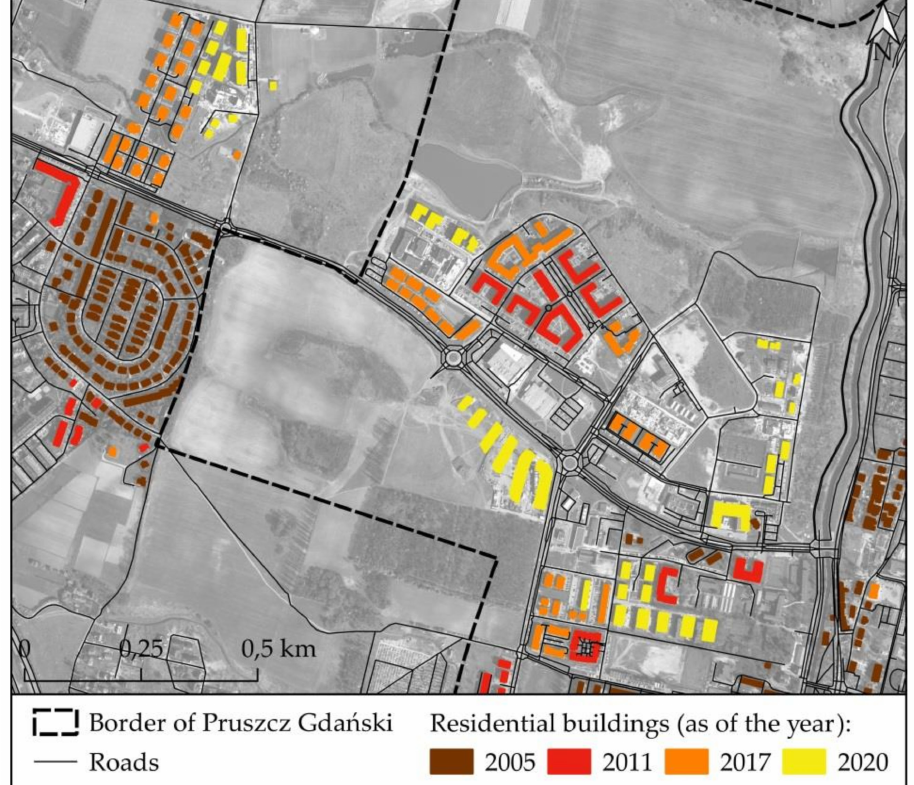
Figure 4. Changes in housing development in the area of Pruszcz Gda´nski with the highest develop- ment dynamics in 2005–2020 and in adjacent areas (source: own elaboration based on